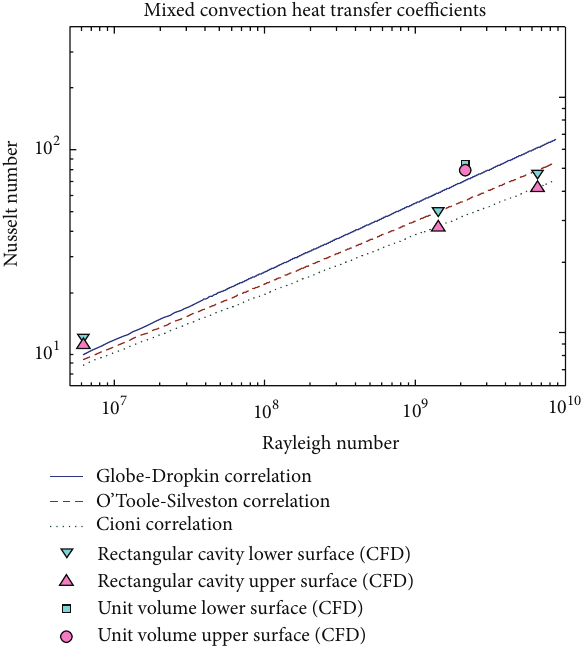
Figure 2: Upward heat transfer coefficients (Rayleigh-Benard con- vection).